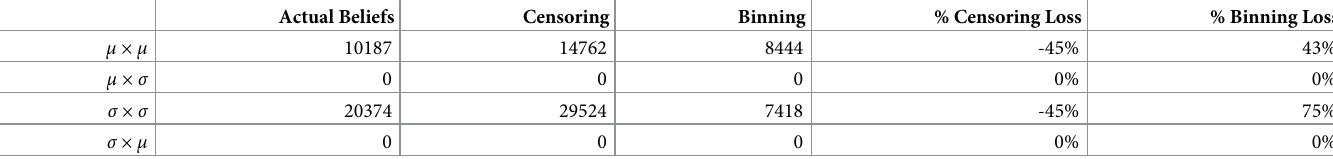
Table 2. Fisher information for N ( μ = 3, σ = 1) beliefs with an ‘unbalanced’ Likert mapping.